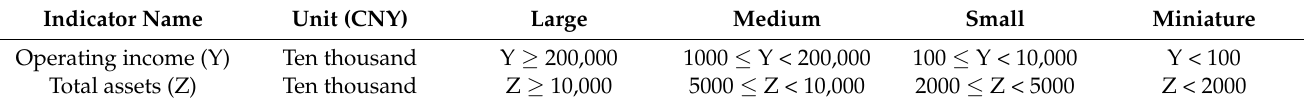
Table 1. Standards for the scale of real estate